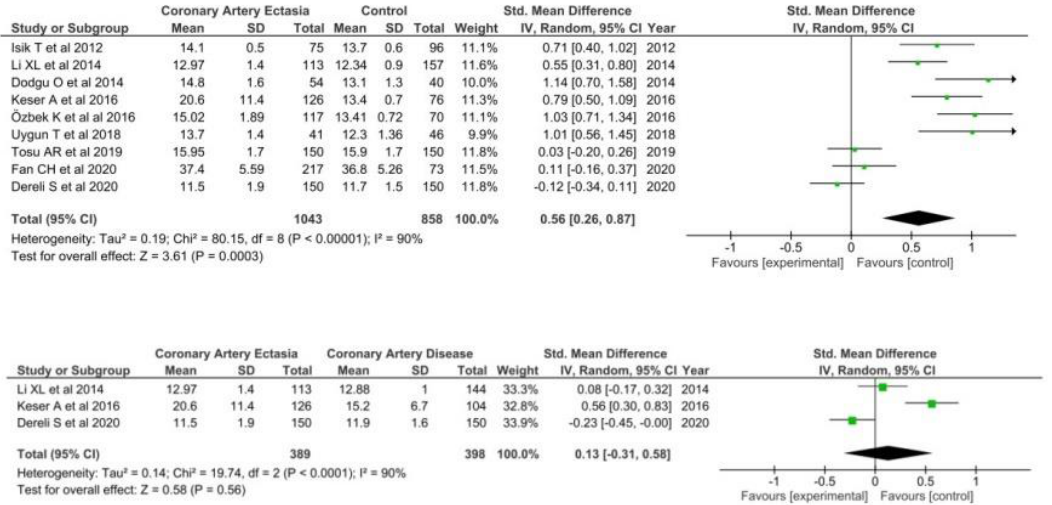
Figure 6. RDW in CAE patients versus controls ( top ) and CAE versus CAD patients ( bottom ). A total of three studies [38,63,70] reported RDW levels on patients with CAE and CAD, including 787 patients in both groups. No differences were found in patients with CAE as compared with patients with CAD (SMD = 0.13; 95% CI: − 0.31 – 0.58).